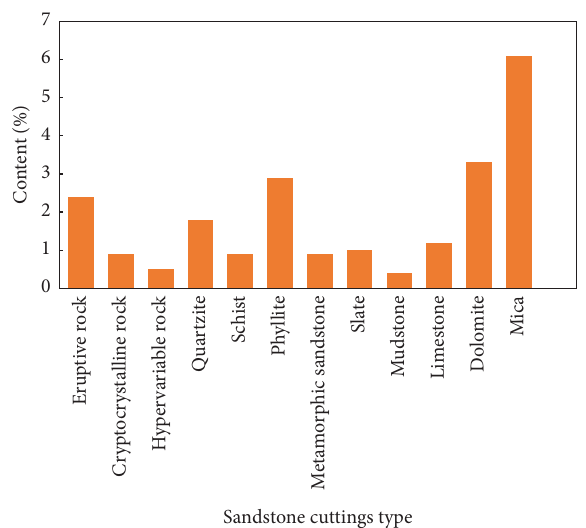
Figure 4: Histogram of cuttings types and contents of sandstone in long 6 segments of Yanchang